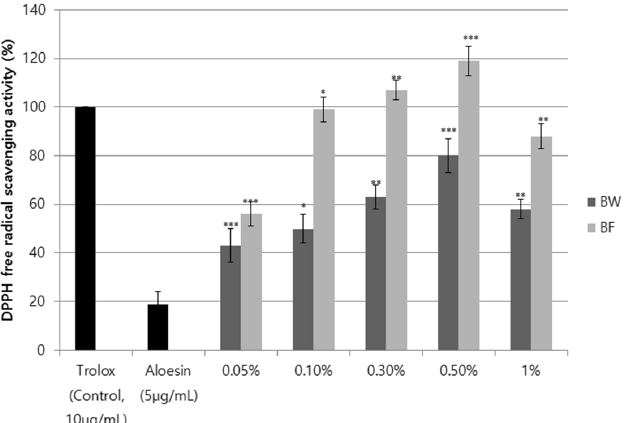
Figure 3. DPPH free radical scavenging activities of two aloe skin leaf extracts compared with 5 µ g/mL aloesin and 10 µ g/mL Trolox. BW: Water extract of aloe skin leaf at 100 ◦ C for 24 h. BF: Fermented extract of aloe skin leaf fermented with L. plantarum BN41 at 37 ◦ C for 3 days and further extracted by an ultrasound generator at 20 kHz for 4 h. The mean values ± SD for separate triplicate experiments are shown, and error bars represent the SD. The significance of the difference was set to * p < 0.05, ** p < 0.01 and *** p < 0.001 compared with two samples, BW and BF.